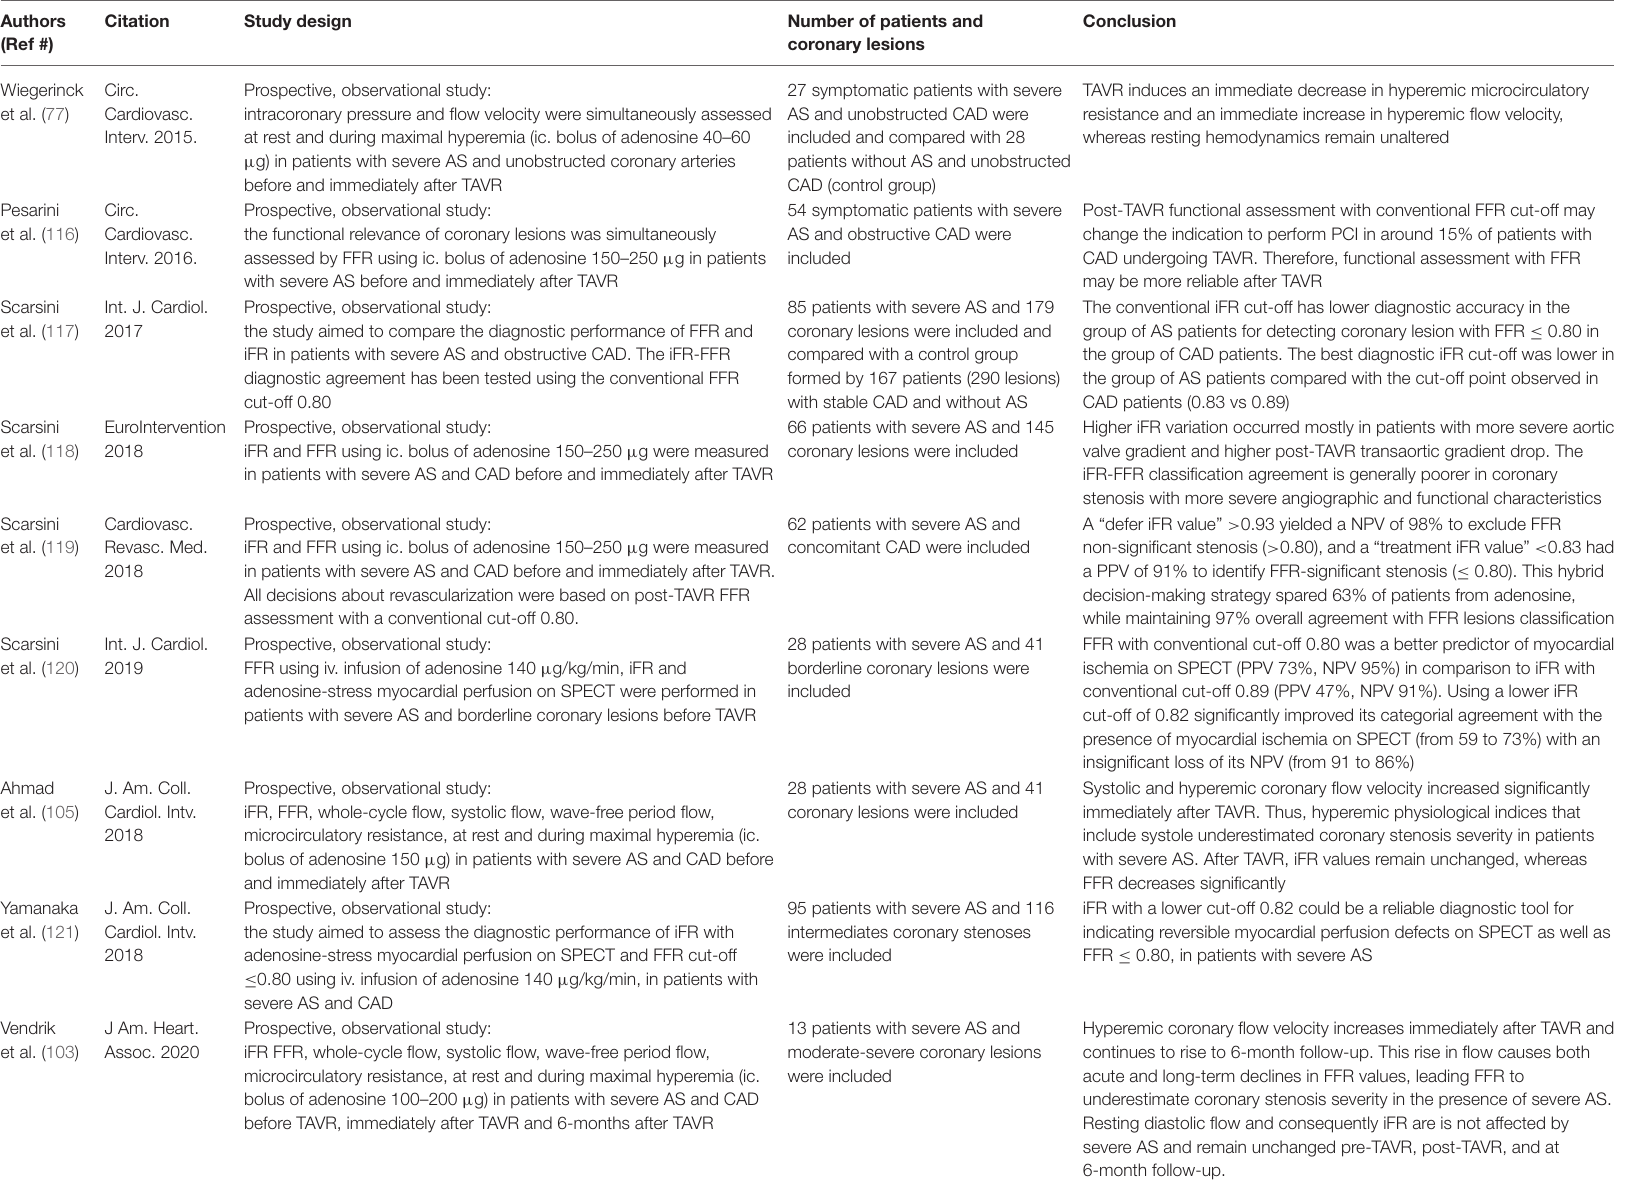
TABLE 1 | Studies evaluating the use of fractional flow reserve (FFR) and instantaneous wave-free ratio (iFR) in patients with severe aortic stenosis (AS) and co-existing coronary artery disease (CAD) before and after transcatheter aortic valve replacement